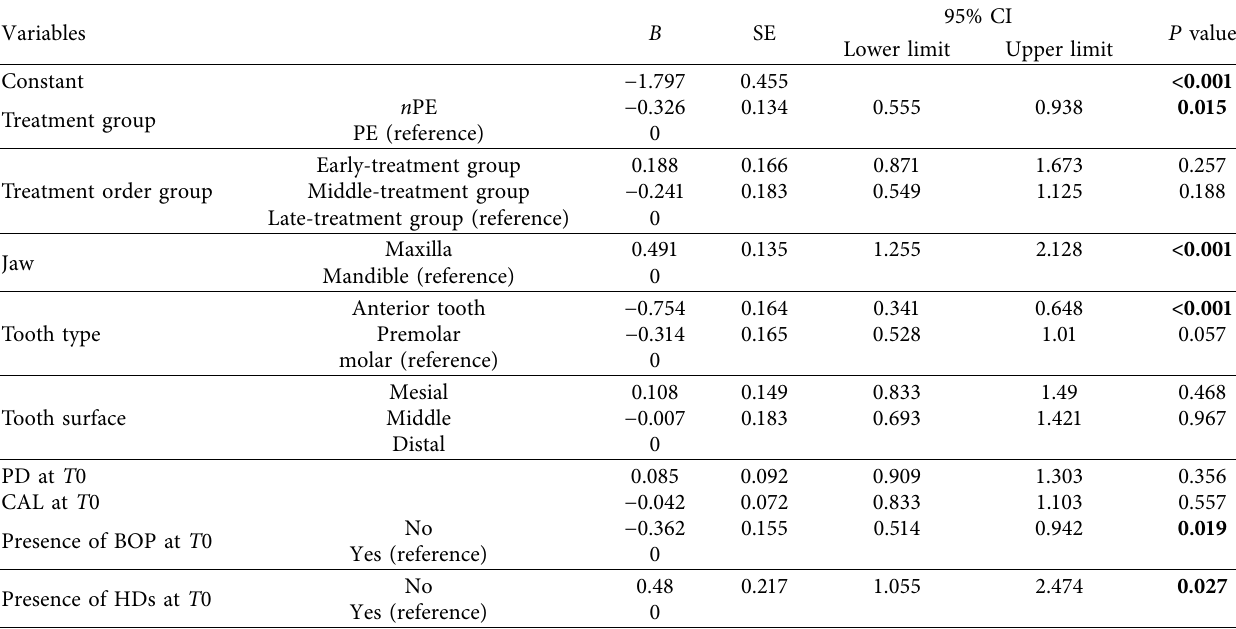
Table 5: Results of multinomial logistic regression analysis at tooth surface